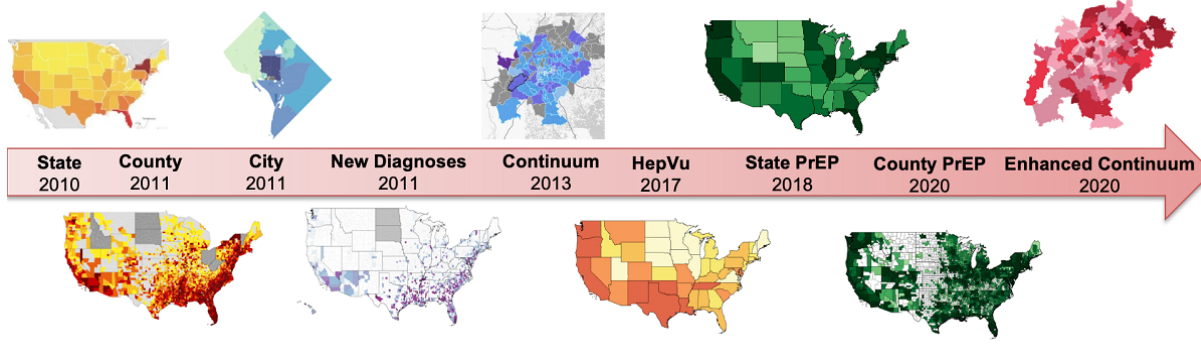
Figure 1. Historical progression of AIDSVu.org data presentations from 2010 to 2020. PrEP: pre-exposure prophylaxis. Hep: hepatitis